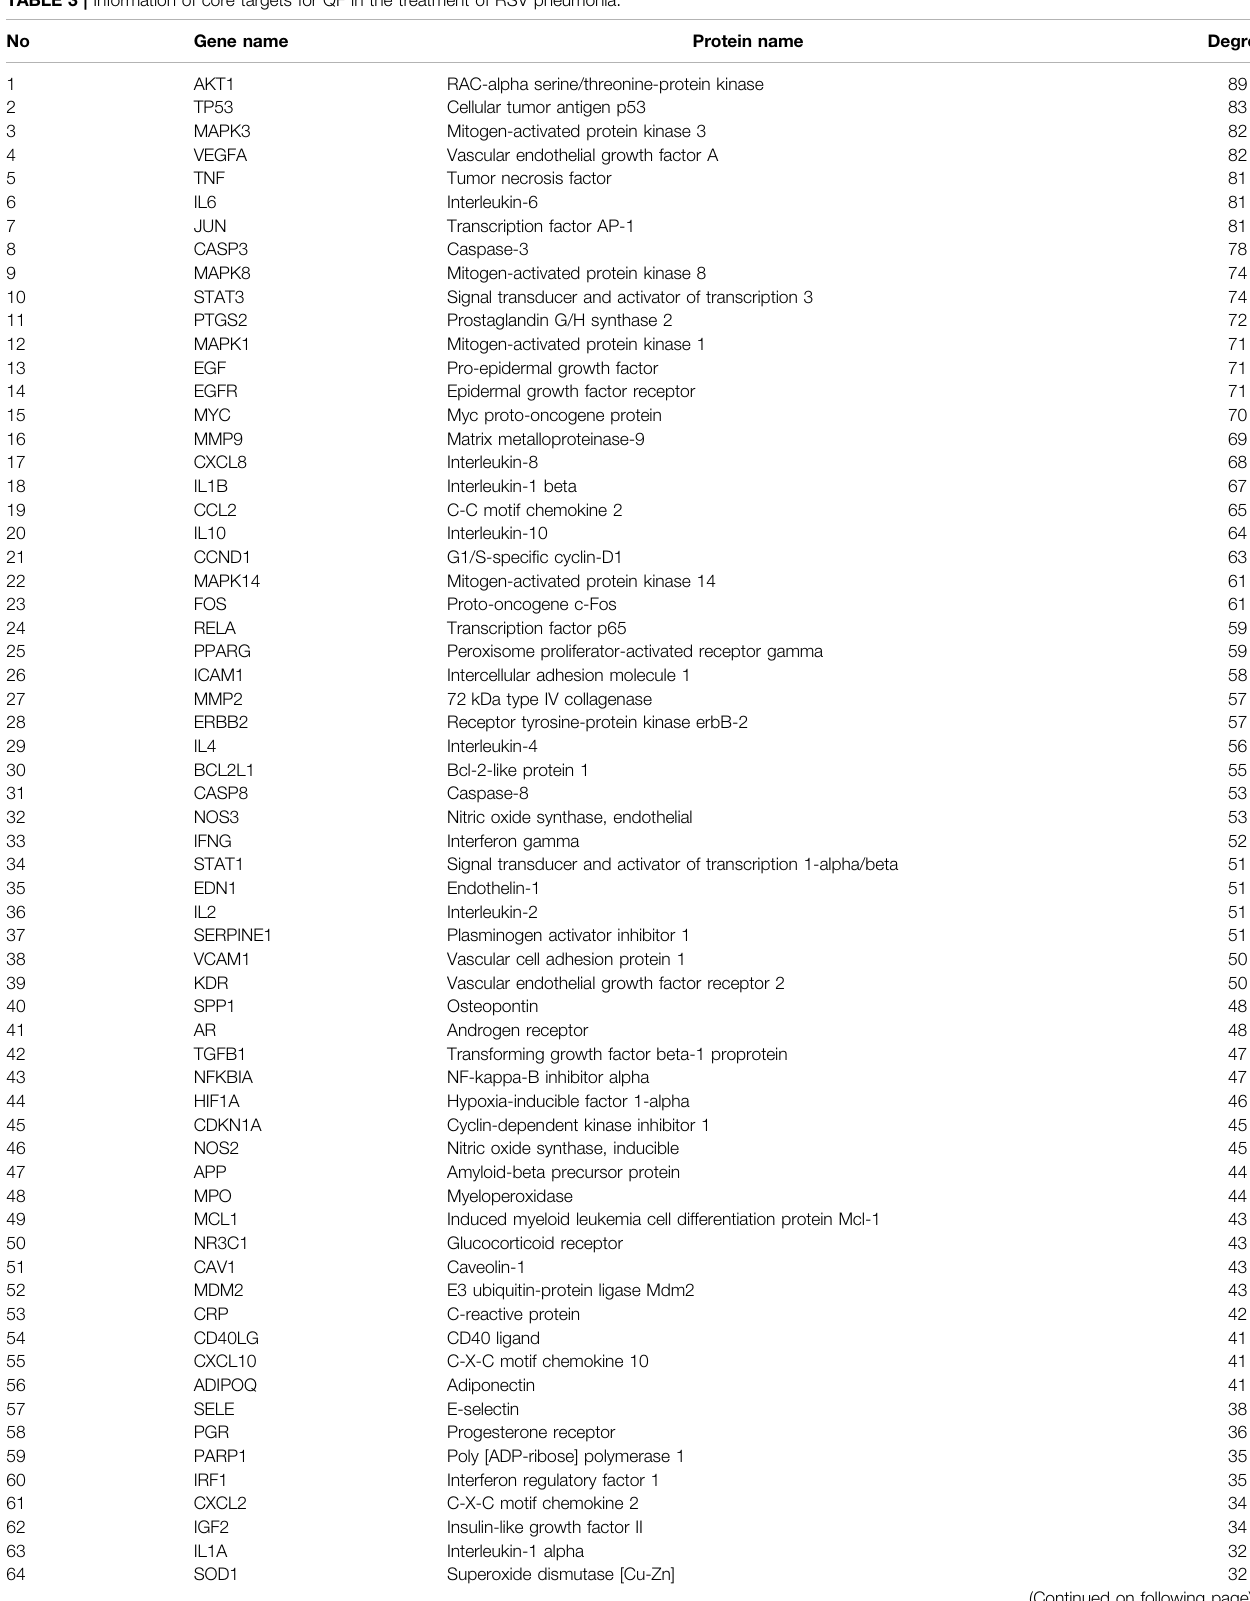
TABLE 3 | Information of core targets for QF in the treatment of RSV pneumonia.